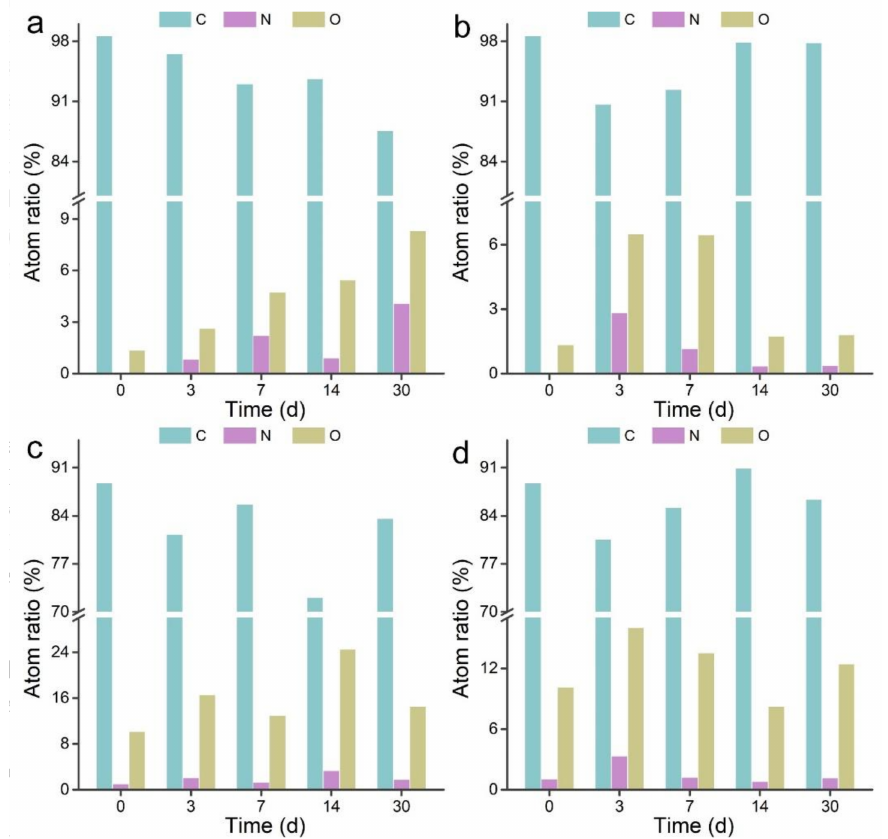
Figure 3. Chemical components of MWCNTs after the incubation with P. chrysosporium . ( a ) Wrapped p-MWCNTs; ( b ) precipitated p-MWCNTs; ( c ) wrapped o-MWCNTs; ( d ) precipitated